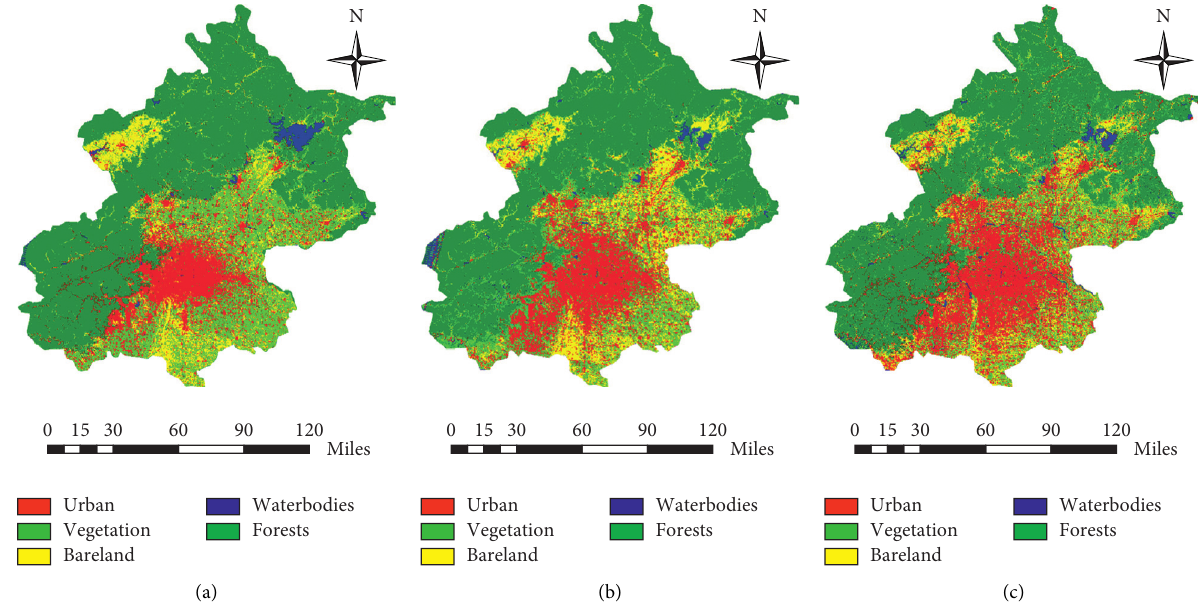
Figure 3: Land use pattern by year in Beijing. (a) 1995, (b) 2004, and (c)